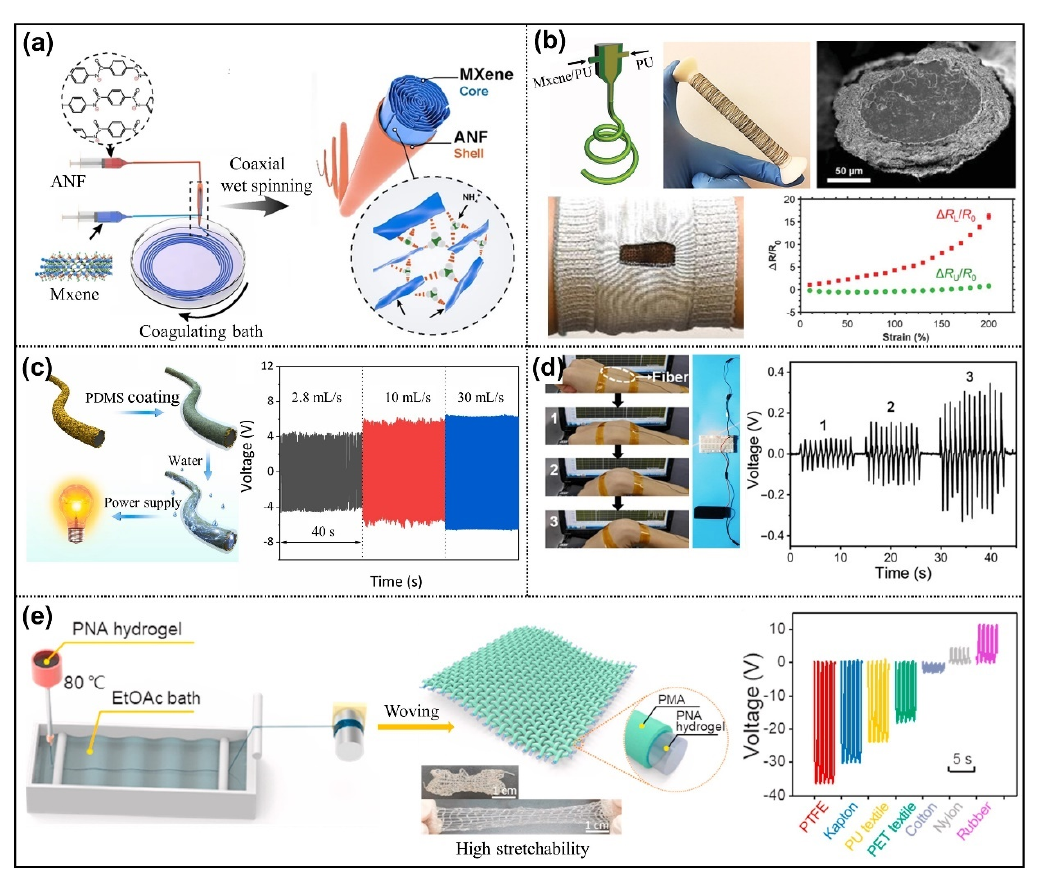
Figure 5. Preparation of micron fiber ‐ based electrode materials applied for energy harvesting by wet spinning method. ( a ) Tough and stable aramid nanofiber/Mxene conductive coaxial fibers. Re ‐